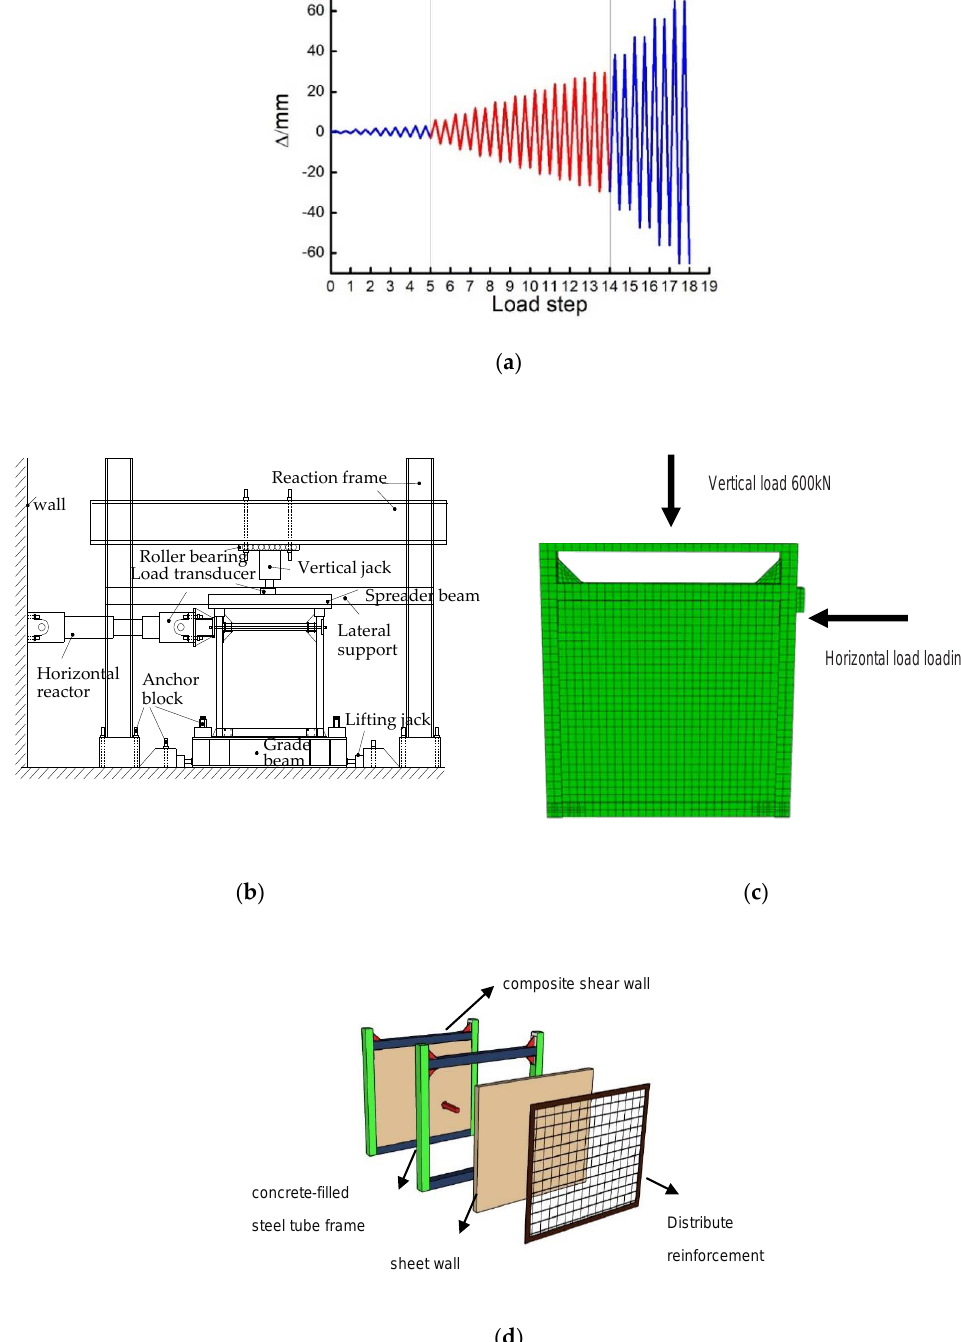
Figure 3. Loading conditions of the test piece. ( a ) Loading scheme, ( b ) diagrammatical sketch of loading device, ( c ) finite element model, and ( d ) composite wall components.